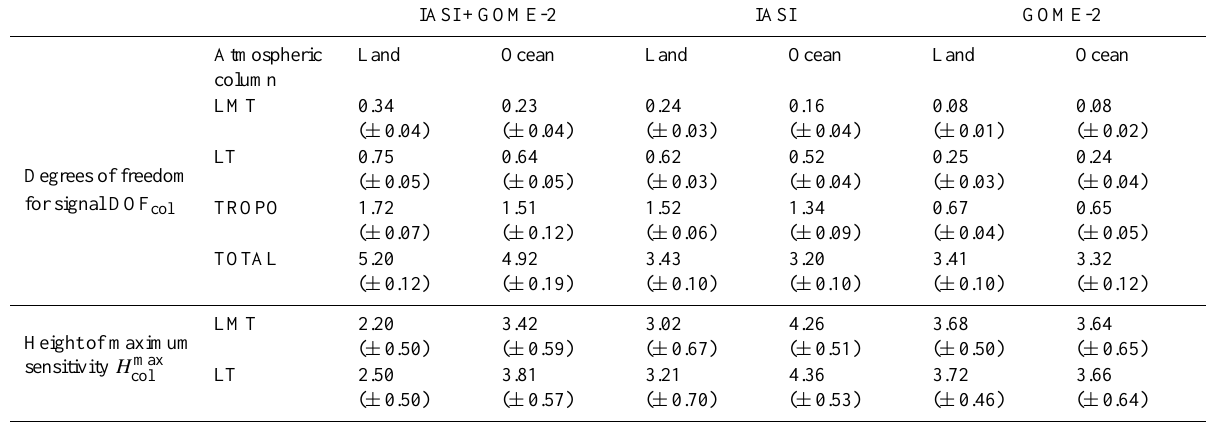
Table 1. Sensitivity of the multispectral ozone retrieval IASI+GOME-2 (UV+TIR) and comparison with IASI (TIR) and GOME-2 (UV) only retrievals. Degrees of freedom for signal and the height of maximum sensitivity (km a.g.l.) are given for different atmospheric partial columns (LMT, LT, TROPO and TOTAL are respectively from the surface up to 3, 6, 12 and 60km a.s.l.). Statistics are given in mean values and standard deviations (with respect to the average, in parenthesis) for all pixels over land and over ocean on 19–20 August 2009 for the region shown in Fig. 2. In order to compare partial columns of similar depths, we consider only land pixels with ground altitudes below 300m a.s.l. For these pixels, the average thermal contrast is 4.4 ± 2.4K over land and 0.9 ± 1.5K over